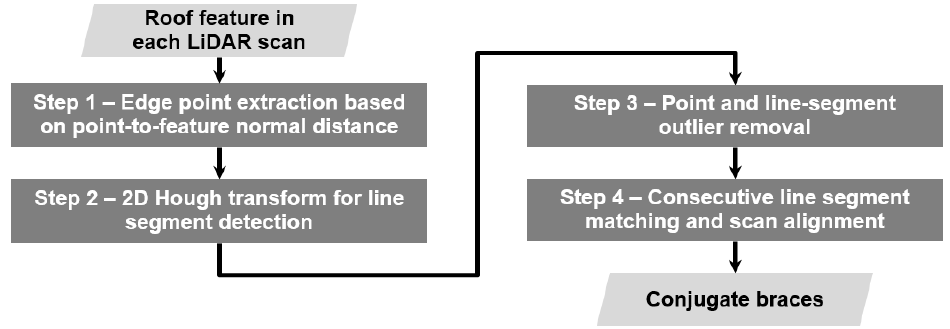
Figure 14. Workflow for the extraction and matching of roof stringers in SMART scans. Step 1 aims at identifying points within the extracted roof surface that belong to stringers (hereafter, these points will be denoted as edge points). Edge points will be extracted as those that have considerable negative normal distance when compared to their local neighborhood, relative to the defined quadratic surface of the dome (one should note that points below the quadratic surface will have negative normal distance). To initiate the edge point extraction, we start by deriving the signed normal distance, d r , between a query point and the quadratic roof surface (estimated in the previous step). Deriving considering a vertical plane that passes through the dome apex and query point, as shown in Figure 15. Then, the normal distance for the query point ( r q , z q ) can be estimated through an optimization procedure that determines its projection ( r n , z n ) onto the quadratic curve in Figure 15 (one should note that the quadratic curve of the vertical slice through the query point and dome quadratic surface will have the same parametric coefficients). The used function for the minimization process is represented by a third order polynomial in r n , as per Equation (3). Following the determination of the normal projection of the (cid:113) (cid:0) (cid:1) 2 + (cid:0) (cid:1) 2 r q − r n z q − z n query point, the normal distance d r can be derived as . The signs of the coordinate differences, ( r q − r n ) and ( z q − z n ), are used to determine whether the query point is above or below the quadratic surface. Edge points are established as those with significant negative normal distance when compared to their local